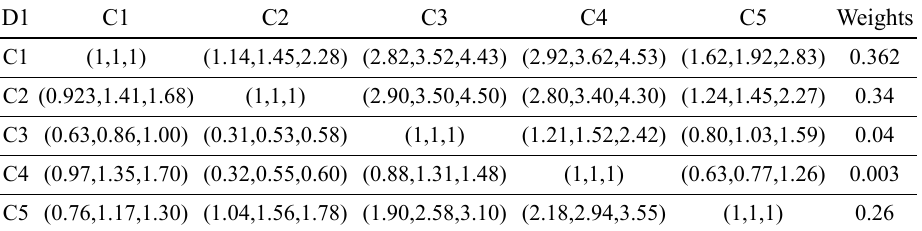
Table 3. Pair-wise comparison matrix and weights under the Relationship Dimension